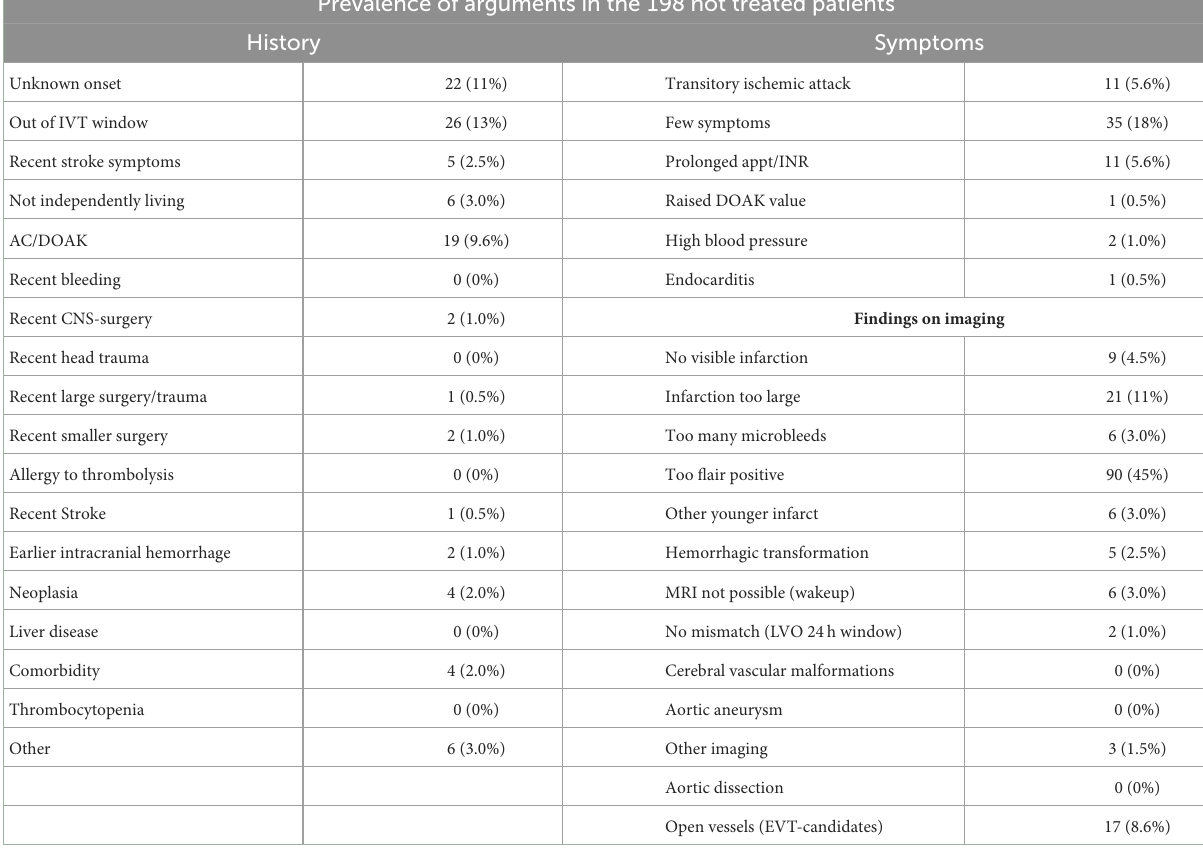
TABLE 1 Prevalence of each argument used in the